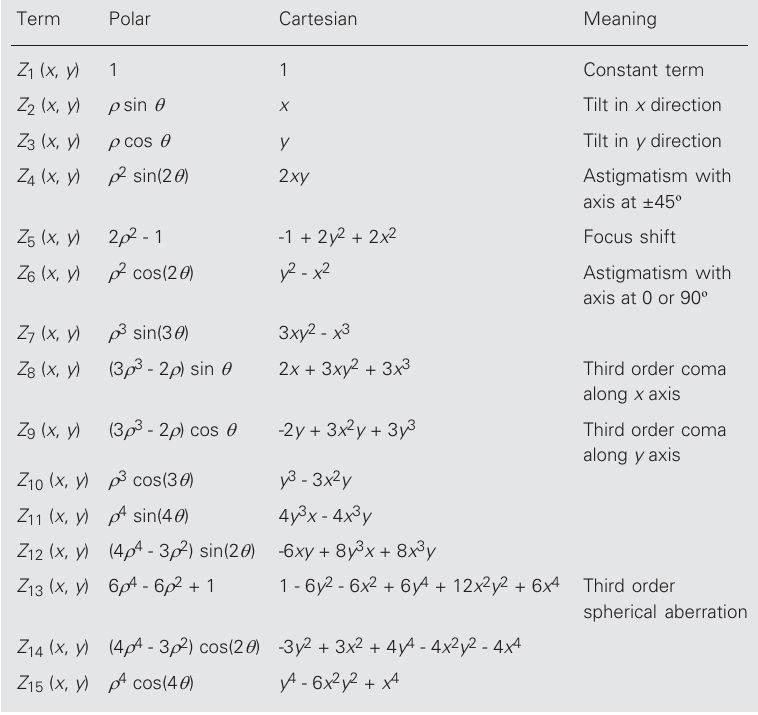
Table 1. Set of the first 15 Zernike polynomials.